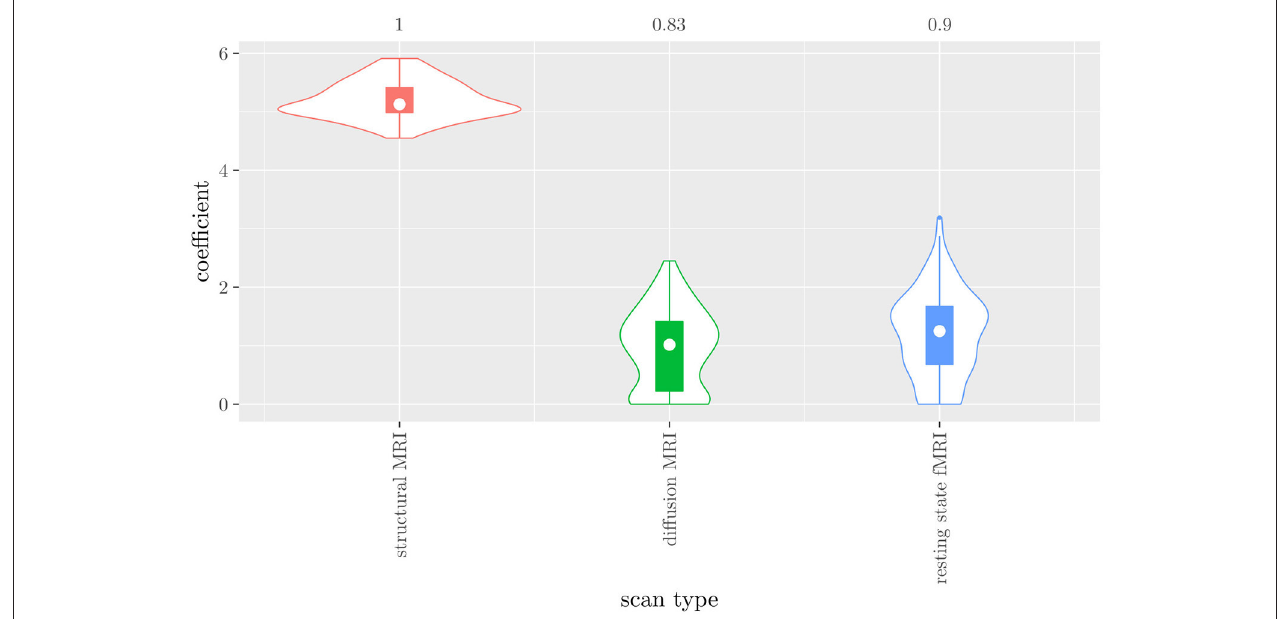
FIGURE 5 | Box-and-violin plots of the hierarchical StaPLR meta-level regression coefficients for each scan type. The numbers at the top of the graph denote the proportion of times the coefficient was nonzero.